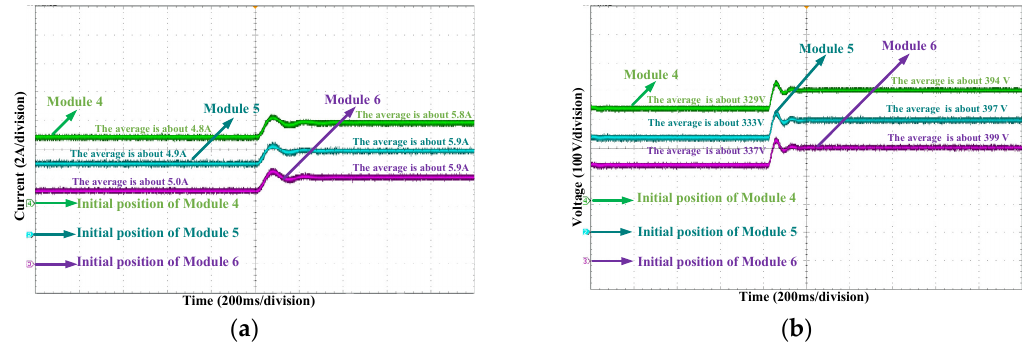
Figure 14. Experimental results of combined converter 2: ( a ) input current of the modules and ( b ) output voltage of the modules.